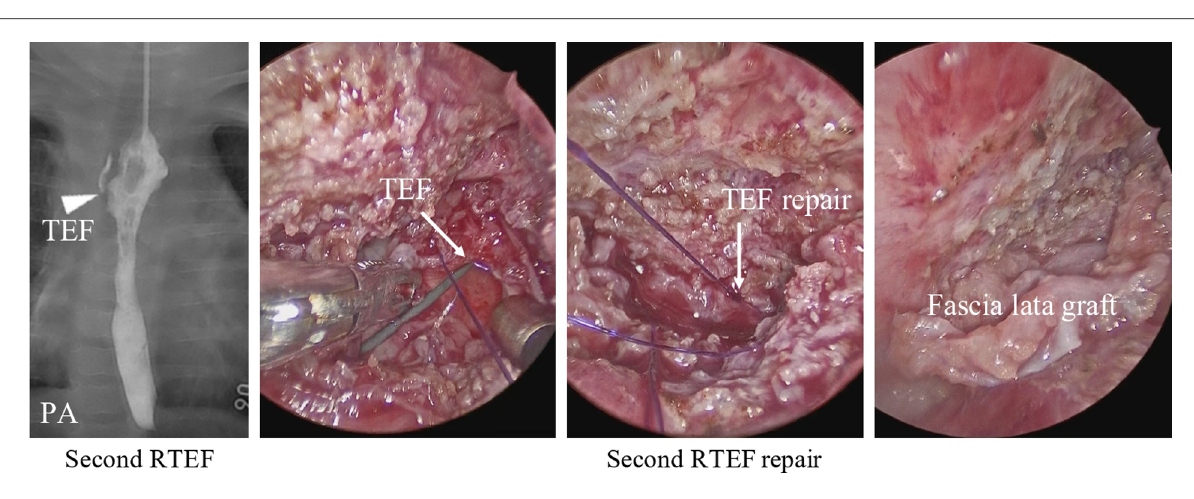
FIGURE 3 A contrast examination of the esophagus shows the second RTEF at the exact location of the fi rst RTEF (arrowhead). During the second RTEF repair, the TEF was closed with sutures with a fascia lata graft (arrow). RTEF, recurrent tracheoesophageal fi